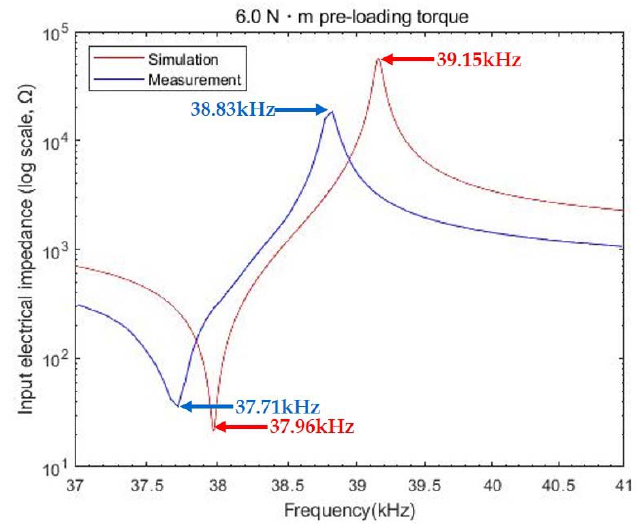
Figure 3. Simulation vs. test result of input impedance for 6.0 N ‧ m torque.